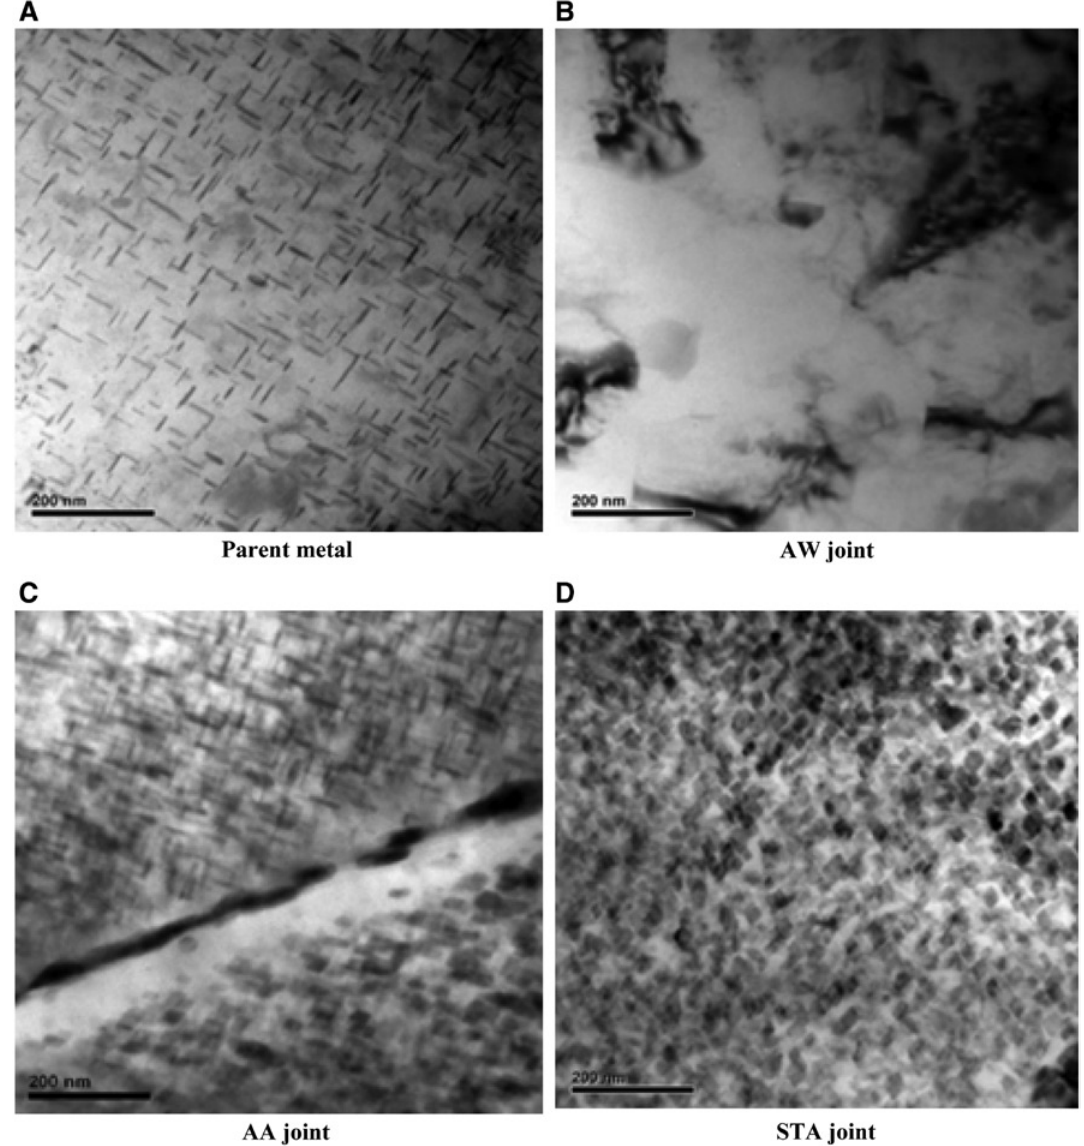
Figure 6: TEM micrograph of the parent metal and stir